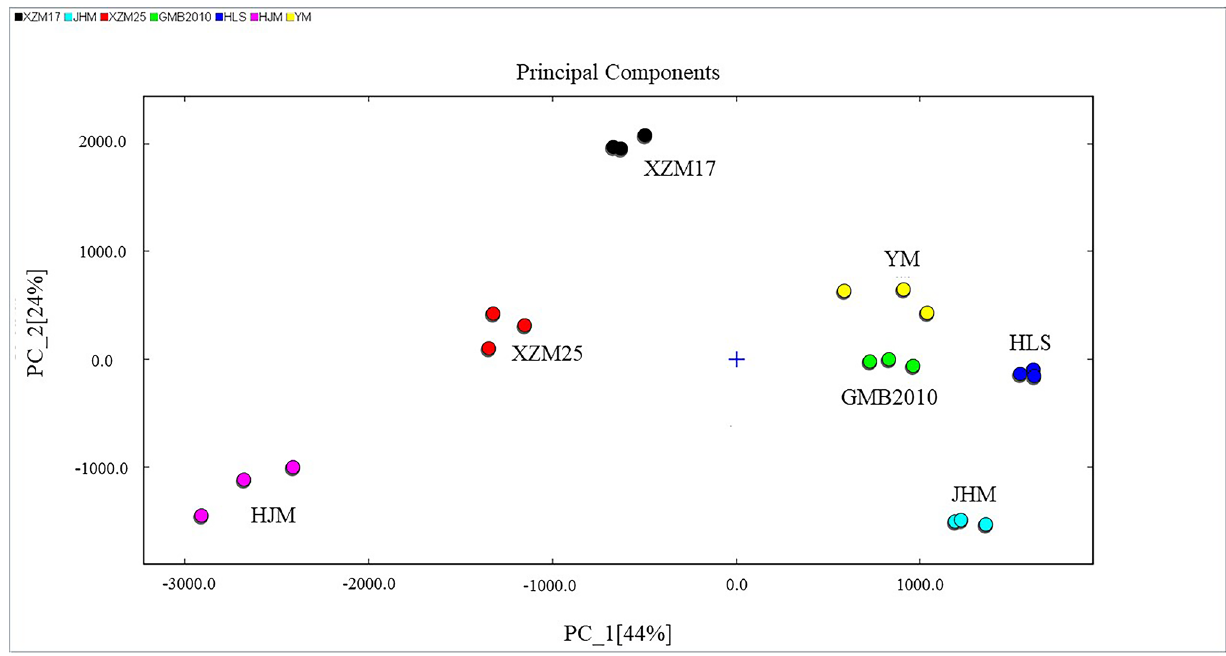
Fig. 6 Principal component analysis of volatile organic compounds in seven cultivars of